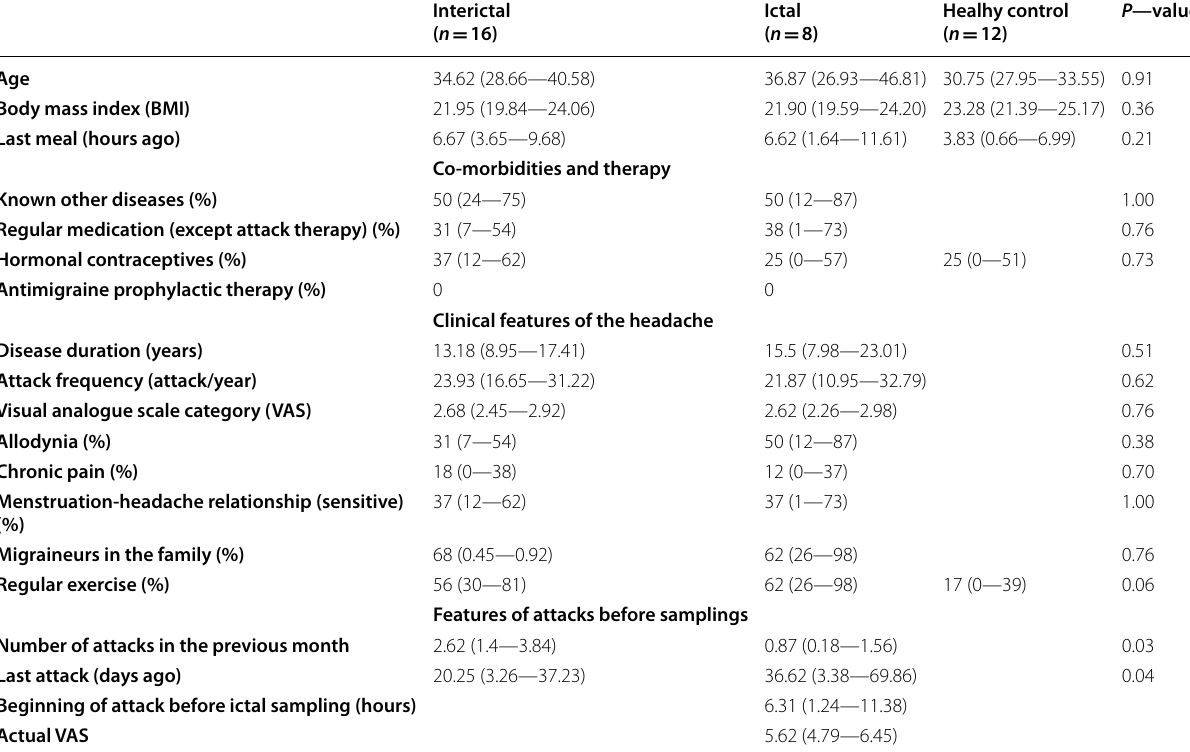
Table 1 Description of the study subjects, main demographic, and clinical characteristics. Mean values (with 95% confidence intervals) of the selected parameters in migraineurs (interictal and ictal phase) and healthy control groups. Headache pain was evaluated with the VAS (visual analogue scale). Categories are as follows: 1–4 grade (1), 5–7 grade (2), 8–10 grade